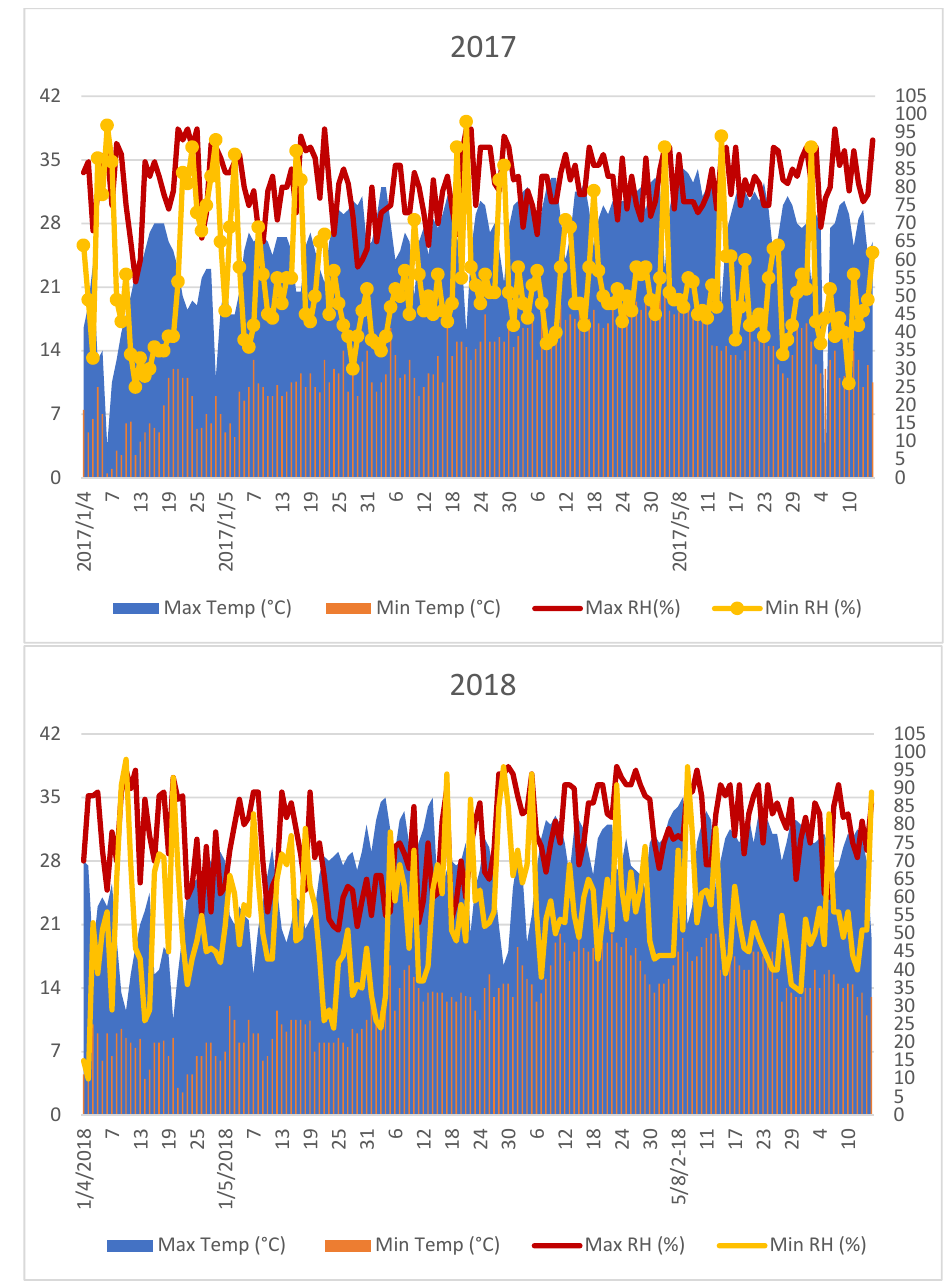
Figure 3. Daily meteorological data during experimental period (2017 and 2018).